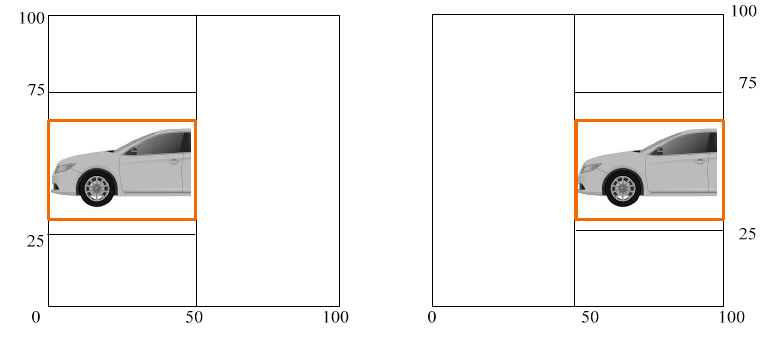
Figure 6. Right and left padding for a detected vehicle.